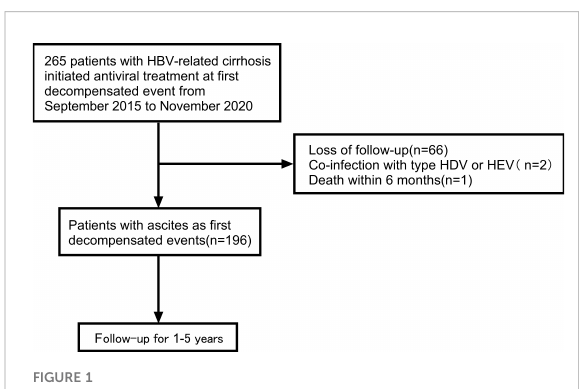
FIGURE 1 Flow chart of the patient selection process. HBV, viral hepatitis B; HDV, viral hepatitis D; HEV, viral hepatitis